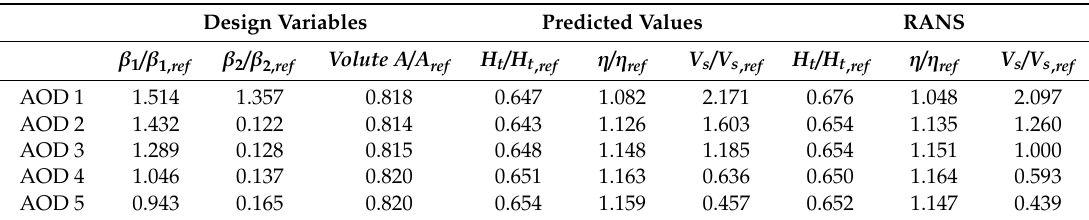
Table 3. Optimization results.